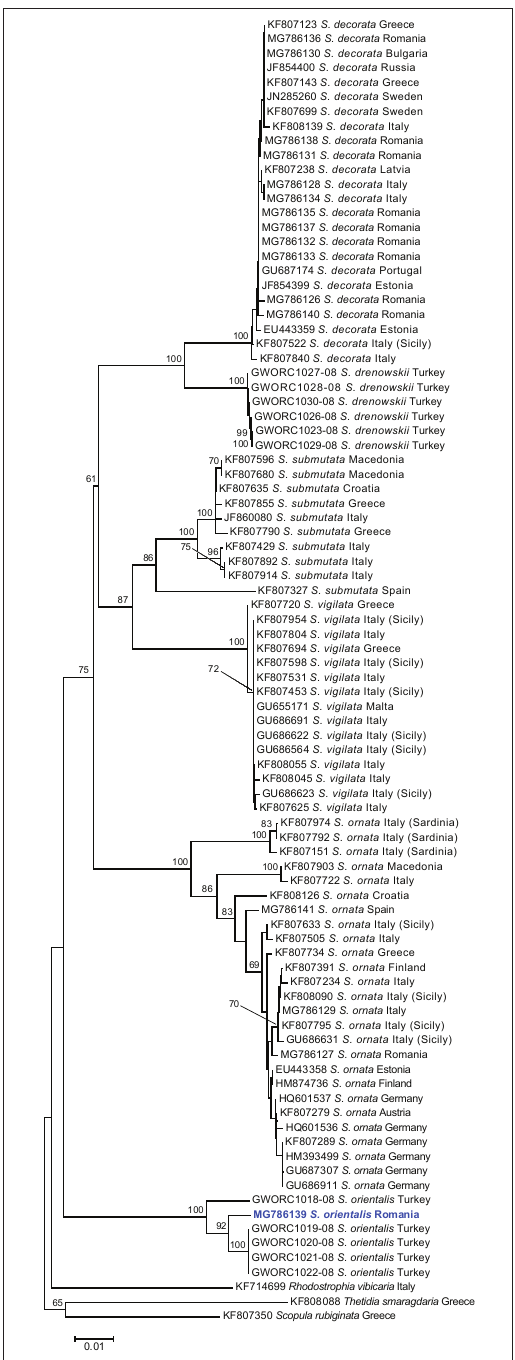
Figure 4. Neighbor-joining tree based on COI sequences highlighting (bold blue) the position of the Romanian specimen of S. orientalis . Bootstrap supports (>60) are shown next to recovered